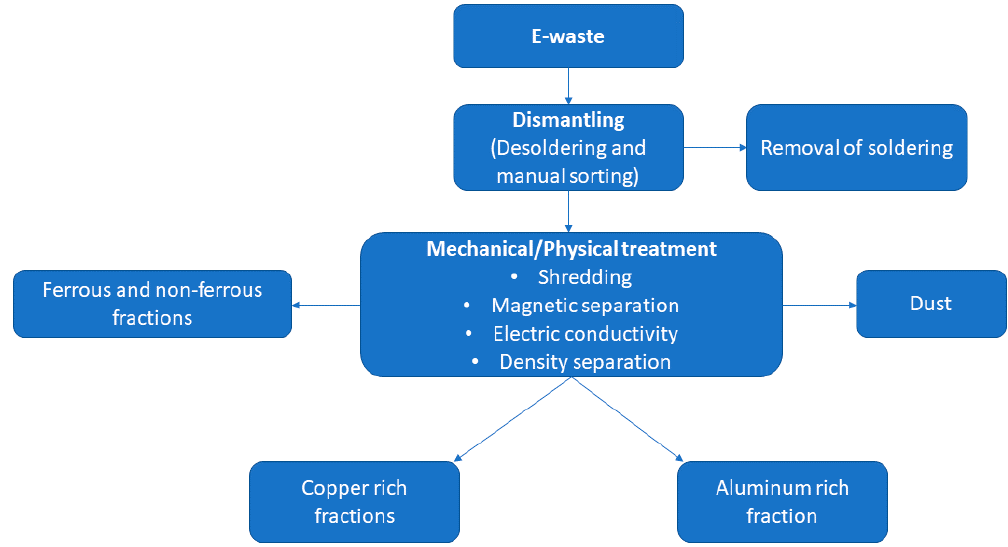
Figure 6. The pretreatment steps for e-waste.